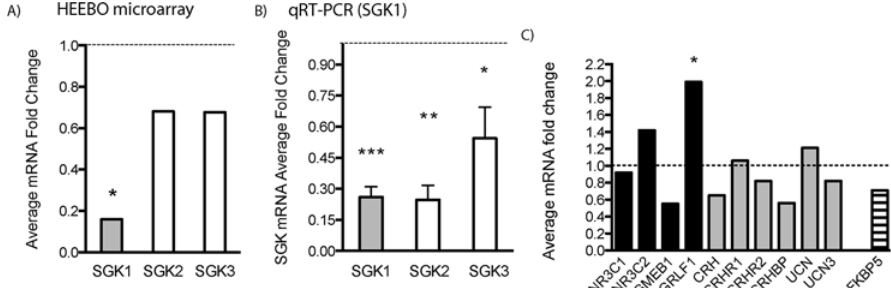
Fig 1. SGK1 expression is significantly decreased in the prefrontal cortex of PTSD patients. (A) Microarray gene expression analysis of postmortem dorsolateral PFC (DLPFC) samples collected from patients with PTSD shows decreased levels of SGK1 mRNA. Microarray analysis demonstrates that levels of SGK2 and SGK3 isoforms are reduced, but these effects were not significant. (B) Real-time qPCR was conducted to verify the microarray findings. Data are expressed as a mean fold change ± standard error of the mean (SEM) ( n = 6), compared to healthy controls ( n = 6). [t(10) = 5.966 for SGK1; t(8) = 4.275 for SGK2; t (8) = 2.057 for SGK3, Student ’ s t test, * p < 0.05, ** p < 0.01, *** p < 0.001]. (C) Expression levels of stress- and glucocorticoid-regulated genes were also examined. Changes are shown as a mean fold change. Asterisk indicates a significant p -value ( * p < 0.05, FDR adjusted). For underlying data, see S1 Data. NR3C1, glucocorticoid receptor; NR3C2, mineralocorticoid receptor; GMEB1, glucocorticoid modulatory element binding protein 1; GRLF1, glucocorticoid receptor DNA binding factor 1; CRH, corticotropin-releasing hormone; CRHR1, corticotropin-releasing hormone receptor 1; CRHR2, corticotropin-releasing hormone receptor 2; CRHBP, corticotropin-releasing hormone binding protein; UCN, urocortin; UCN3, stresscopin (urocortin 3); FKBP5, FK506 binding protein